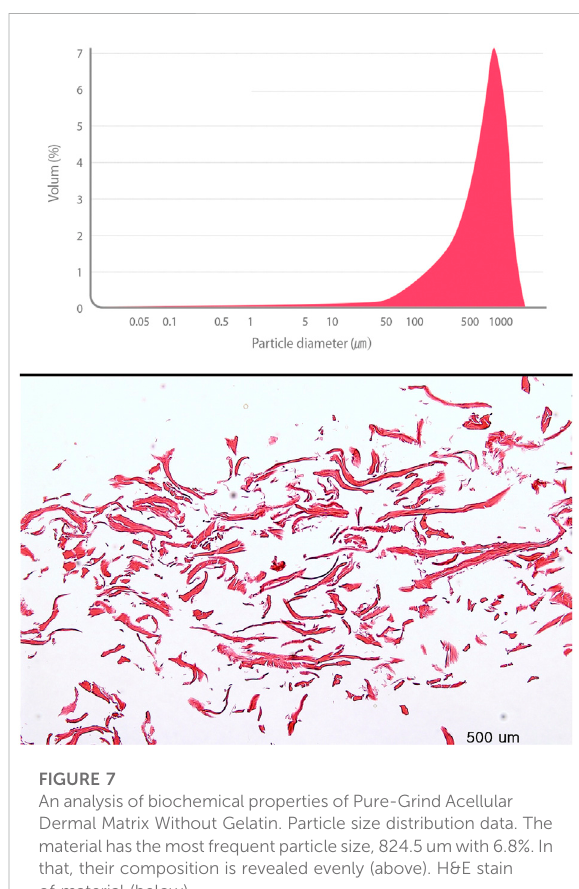
FIGURE 7 An analysis of biochemical properties of Pure-Grind Acellular Dermal Matrix Without Gelatin. Particle size distribution data. The materialhasthemostfrequentparticlesize,824.5umwith6.8%.In that, their composition is revealed evenly (above). H&E stain of material